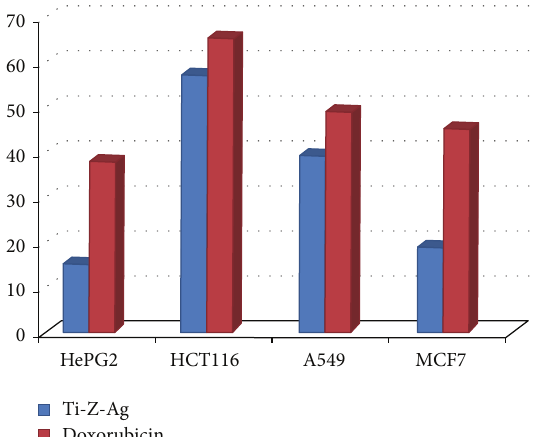
Figure 6: LC 50 𝜇 M of the prepared Ti-Z-Ag against carcinoma cell line compared with doxorubicin (positive